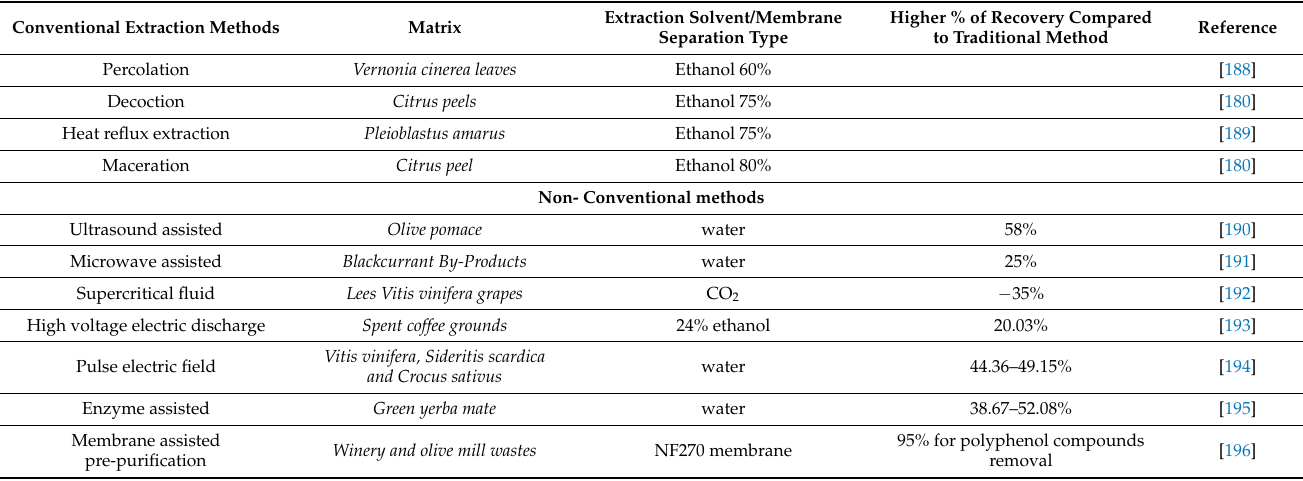
Table 1. Extraction of free and bound